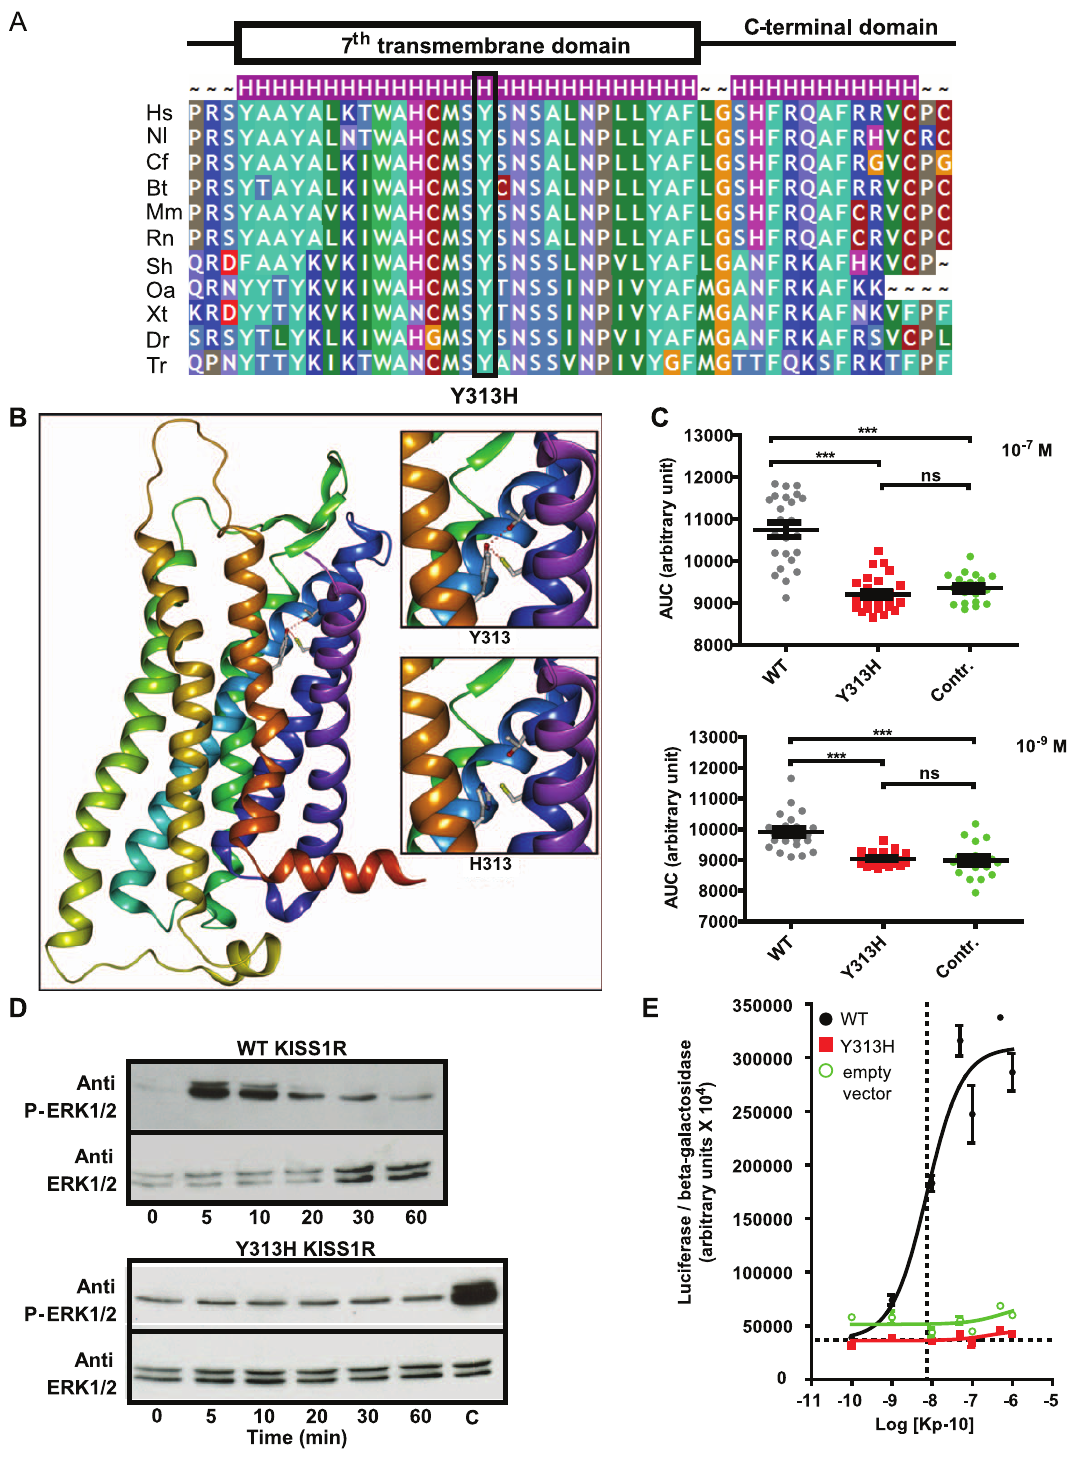
Figure 3. Modeling and functional consequences of the p.Tyr313His KISS1R mutation. Panel A. Evolutionary conservation of Tyr313. Tyr313 is totally conserved among KISS1R homologs. Hs: Homo sapiens; Nl: Nomascus leucogenys; Cf: Canis familiaris; Bt: Bos taurus; Mm: Mus musculus; Rn: Rattus norvegicus; Sh: Sarcophilus harrisii; Oa: Ornithorhynchus anatinus; Xt: Xenopus tropicalis; Dr: Danio rerio; Tr: Takifugu rubripes. The substitution is indicated below. Panel B. Modeling of the transmembrane region of KISS1R. Tyrosine 313 (and its substitution by a histidine) are located at the bottom of the putative binding pocket for kisspeptin. Tyr313 is in a suitable position to form two hydrogen bonds with Cys95 and Thr99 (see upper insert), both located in the second transmembrane segment. The His substitution abolishes these interactions (lower insert). Panel C. Variation of intracytoplasmic calcium concentrations in WT, Tyr313His (Y313H) mutated KISS1R and empty vector. Transfected cells were stimulated by kisspeptin (10 2 7 M and 10 2 9 M): we observe a very significant decrease in calcium release in mutant-KISS1R transfected cells (***p , 0.0001). Each point represents the area under the curve (AUC) for an individual cell. WT: black circles, Y313H: red squares, empty vector green